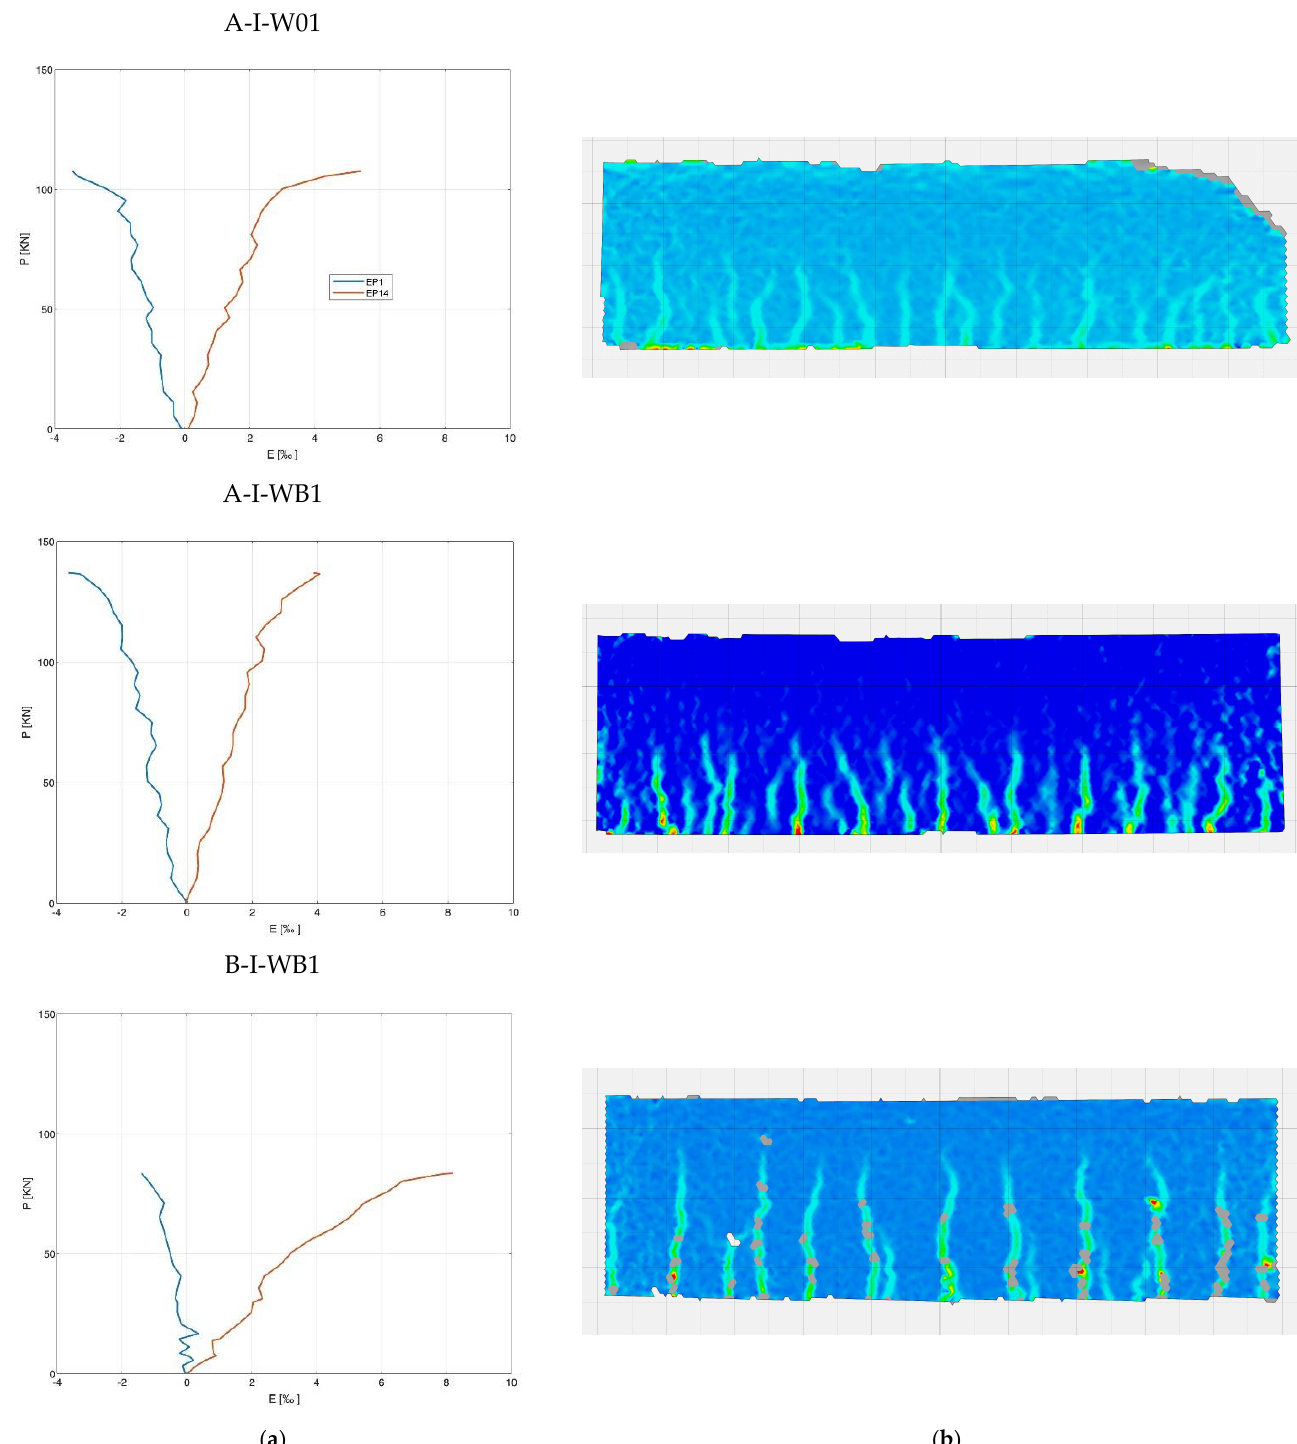
Figure 6. Strains in concrete in series A-I-W01, A-I-WB1, and B-I-WB1. ( a ) The position of longitudinal reinforcement in tension and compression zones; ( b ) Strains in the DIC area.